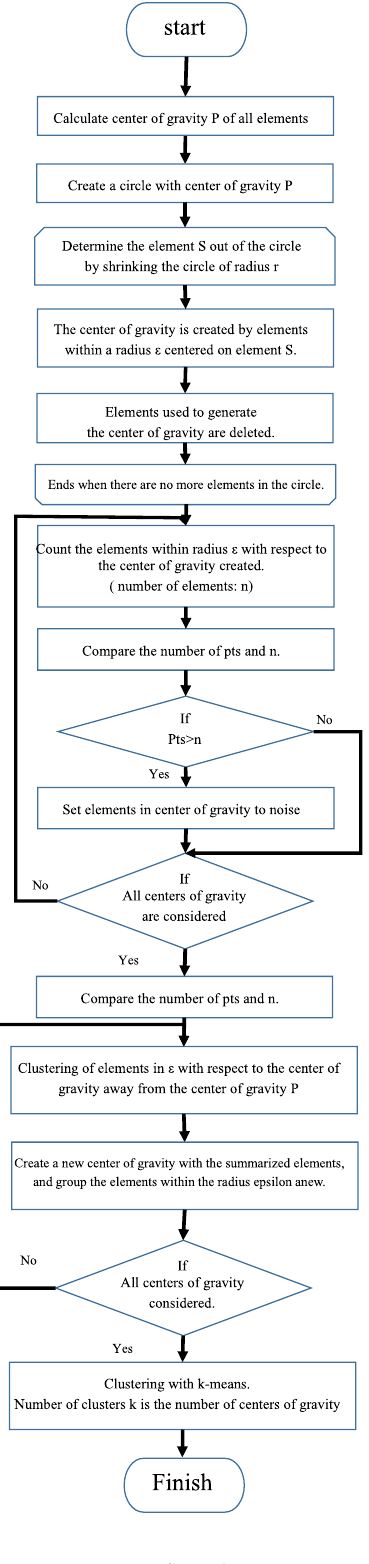
Figure 20. Case 2 flow